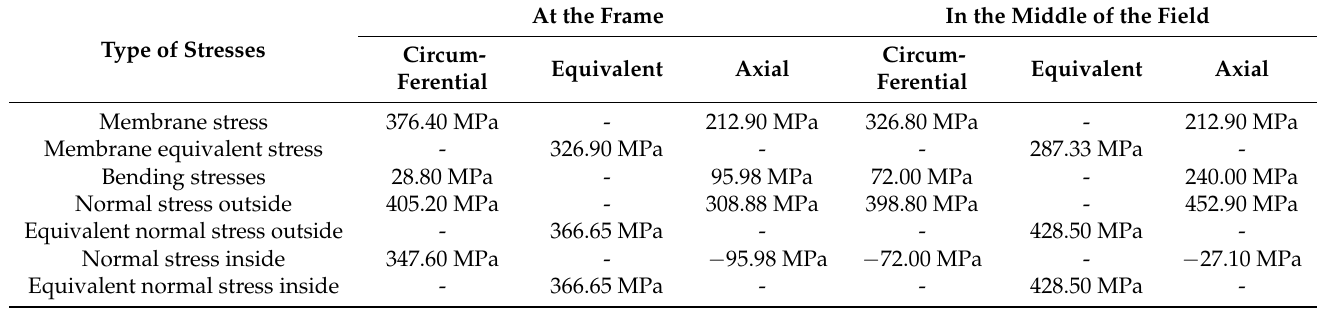
Table A4. Stresses in the free flooding compartment (collapse diving depth) for SST 1: Subsea shuttle tanker (Cargo 10 569 m 3 ).